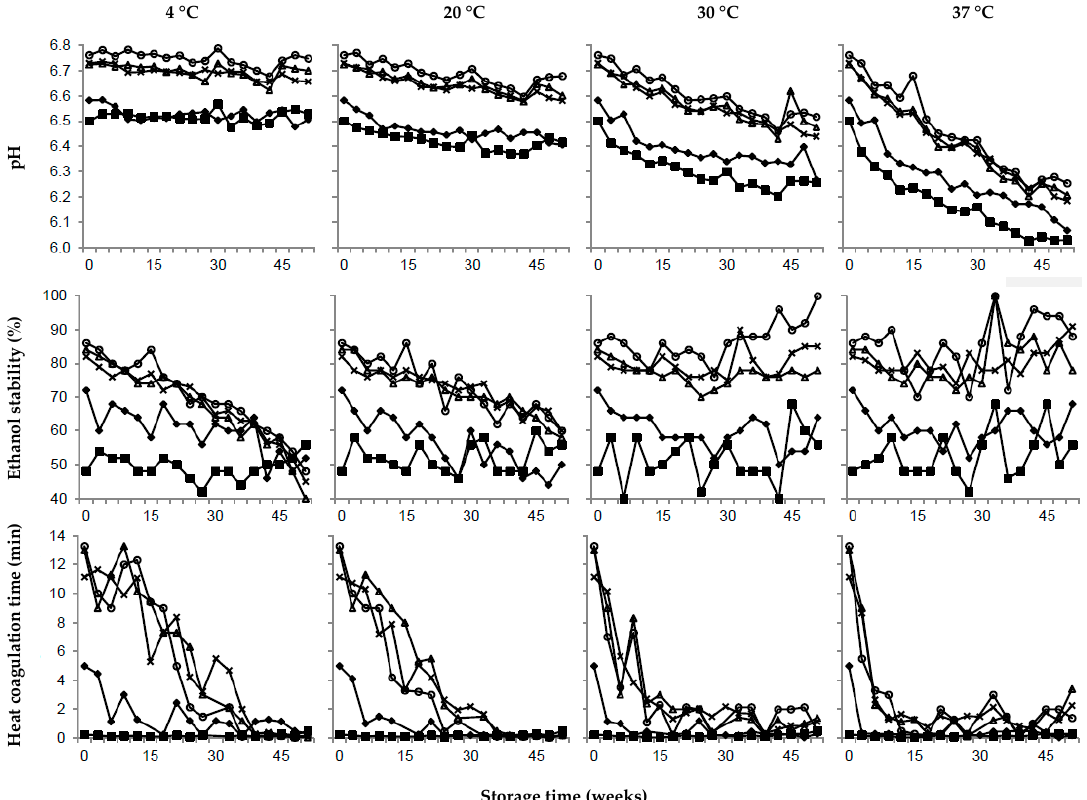
Figure 4. Variation in pH, ethanol stability, and heat coagulation time in ultra-high temperature treated milk for selected samples with elevated levels of ( ■ ) calcium, ( ○ ) citrate, ( ∆ ) urea, ( ♦ ) calcium and citrate, and average values of two batches ( × ) unmodified reference ultra-high temperature treated milk during storage from 0–52 weeks at 4, 20, 30, and 37 °C.